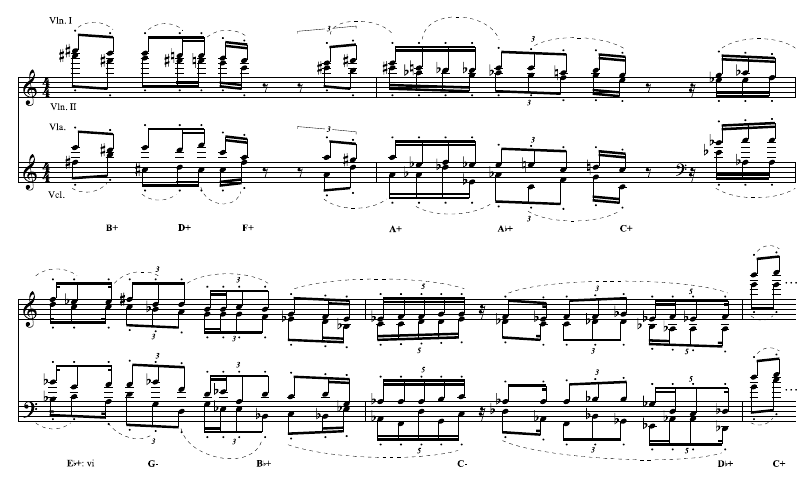
Figure 8. Many Many Cadences (Macklay 2014), measures 25–9. Arts 2017 , 6 , 15